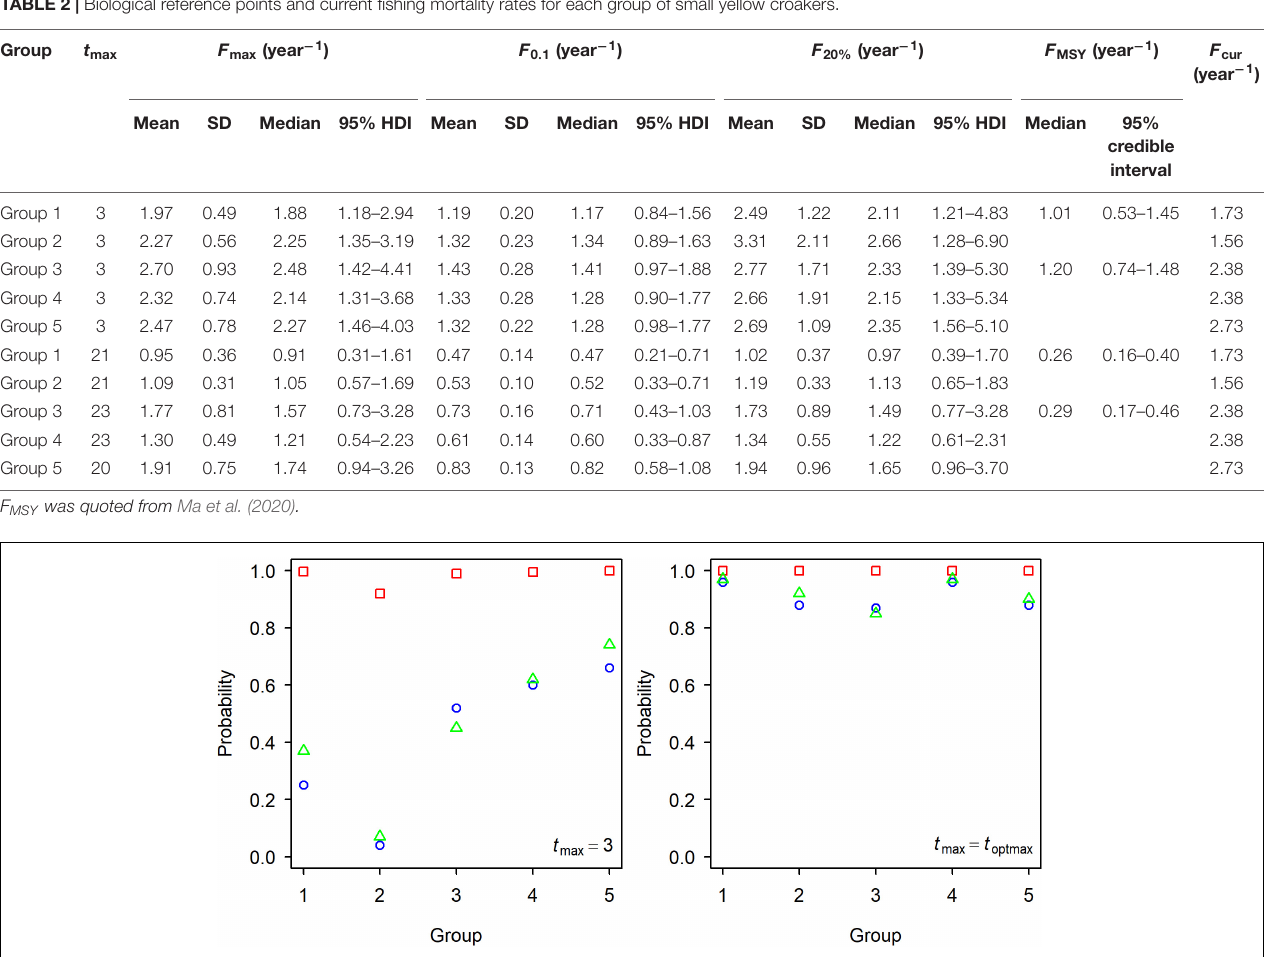
TABLE 2 | Biological reference points and current fishing mortality rates for each group of small yellow croakers.